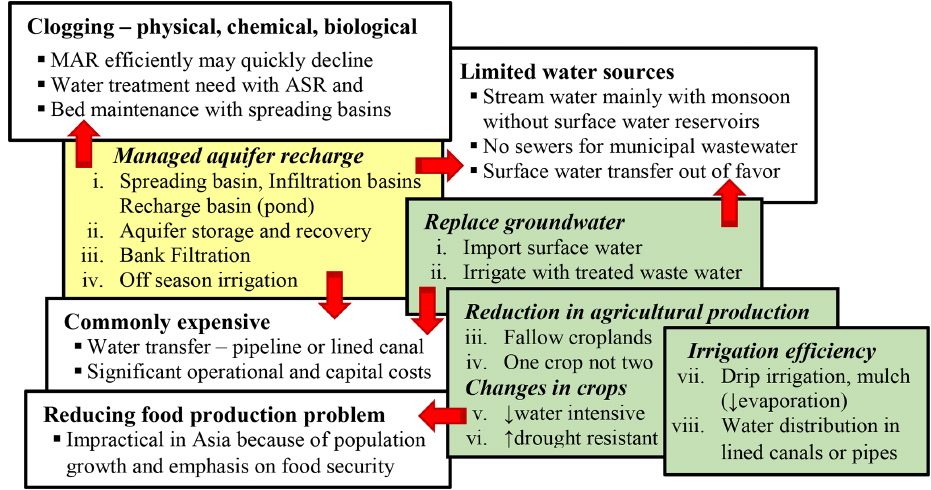
Box 2. The yellow and green boxes list some of the strategies for increasing aquifer storage of groundwater by increasing inflows through managed recharge and/or decreasing the quantity of water pumped, respectively. The red arrows indicate associated